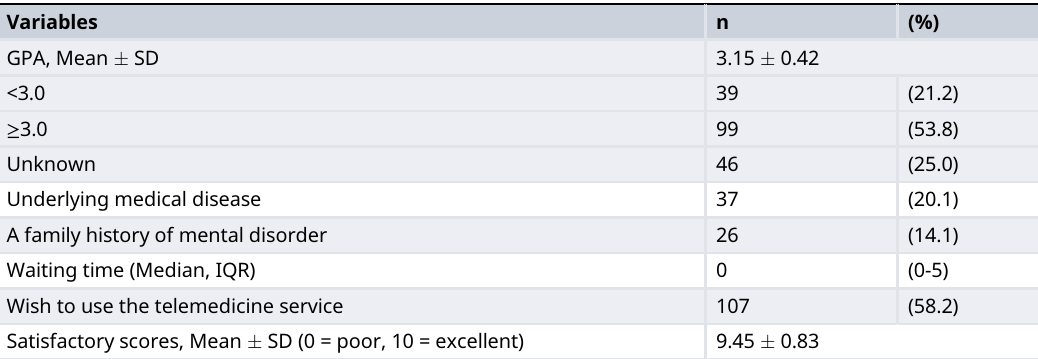
Table 2 demonstrates the prevalence of psychiatric diagnoses. Among all psychiatric disorders, depressive disorders (57.1%), adjustment disorders (15.2%), and anxiety disorders (13.6%) were the top three most common diagnoses. The median number of visits to the mental health service was 7 (IRQ 3-14). Approximately 86% of participants received psychotropic medications. Table 3 reveals the measurement tools used in the mental health service. Around 38% of participants had a CGI scale of 4 (moderately ill). Most participants had mild depression (50%) and low suicidal risk (76.3%) from PHQ-9 and 8Q, respectively. Unsurprisingly, all participants had below-average mental health from TMHI-15. Theresults ofmultivariable regression analysis showed thatGPAs below 3.0(OR = 3.09, 95%CI: 1.17-8.14) and a family history of mental disorders (OR = 3.40, 95%CI: 1.10-10.48) were the independent predictors of moderate to severe mental health problems (Tables 4 and 5).